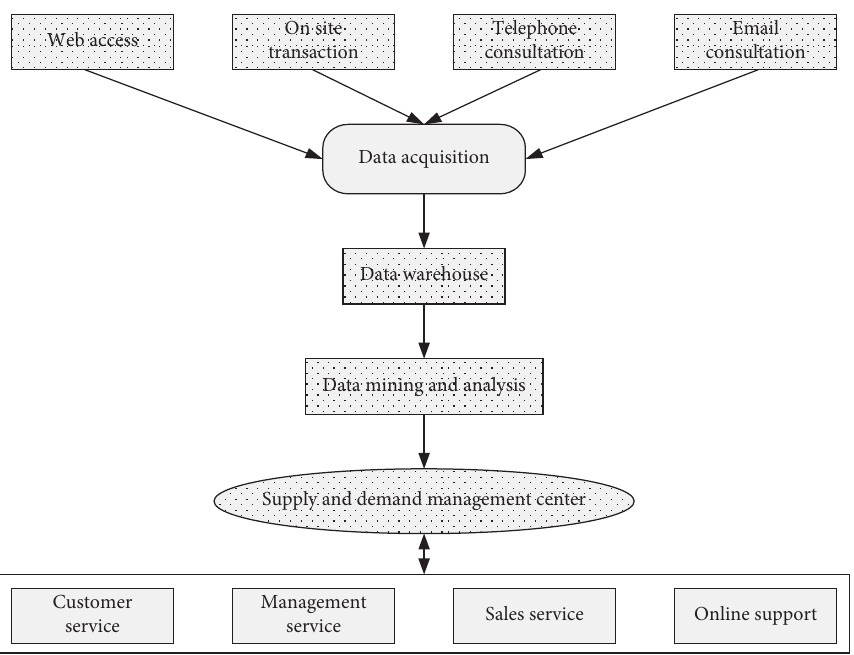
Figure 2: The overall implementation process of the supply and demand relationship platform between enterprises and